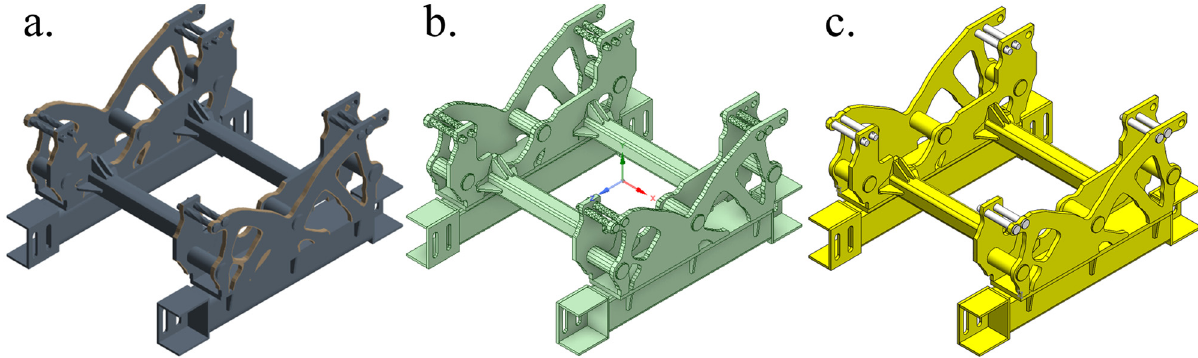
Figure 13: Topology optimized results from PS1 ( * = V 50%, equal weights ) : ( a ) density iso - line using ≥ ρ 0.6 in workbench, ( b ) optimized geometry in SpaceClaim, and ( c ) computer - aided design ( CAD ) model created in SolidWorks.